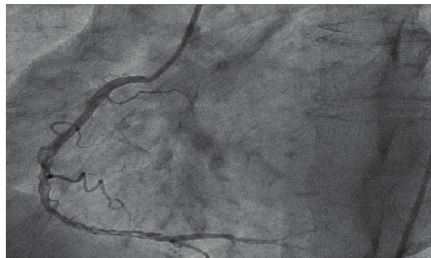
Figure 3: There is normal blood flow at the distal RCA segment of the anomaly.